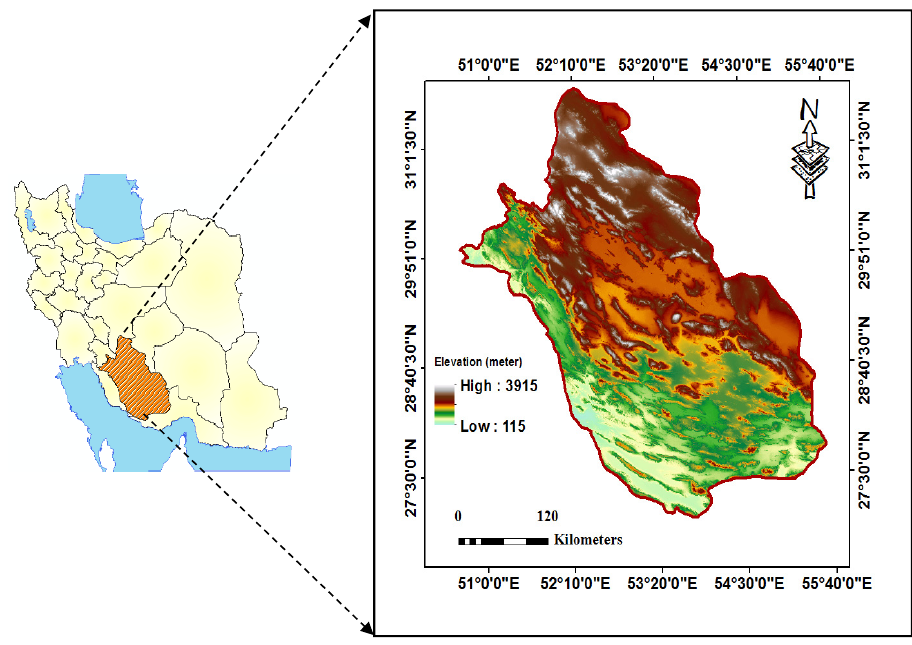
Figure 1. Location of the study area in southern Iran.